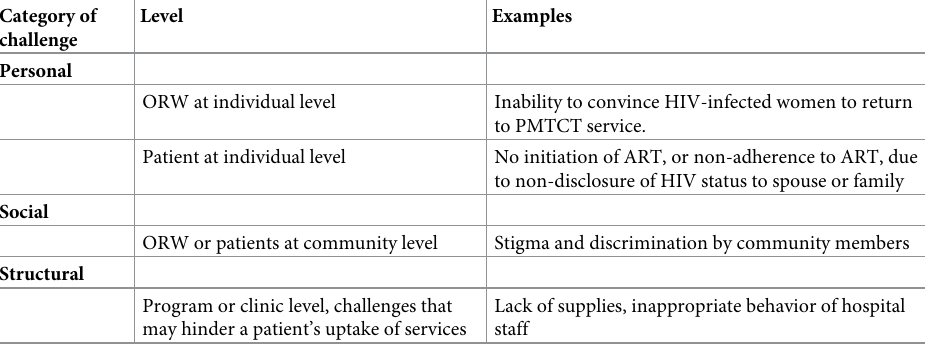
Table 1. Categorization of challenges faced by outreach workers, with levels and